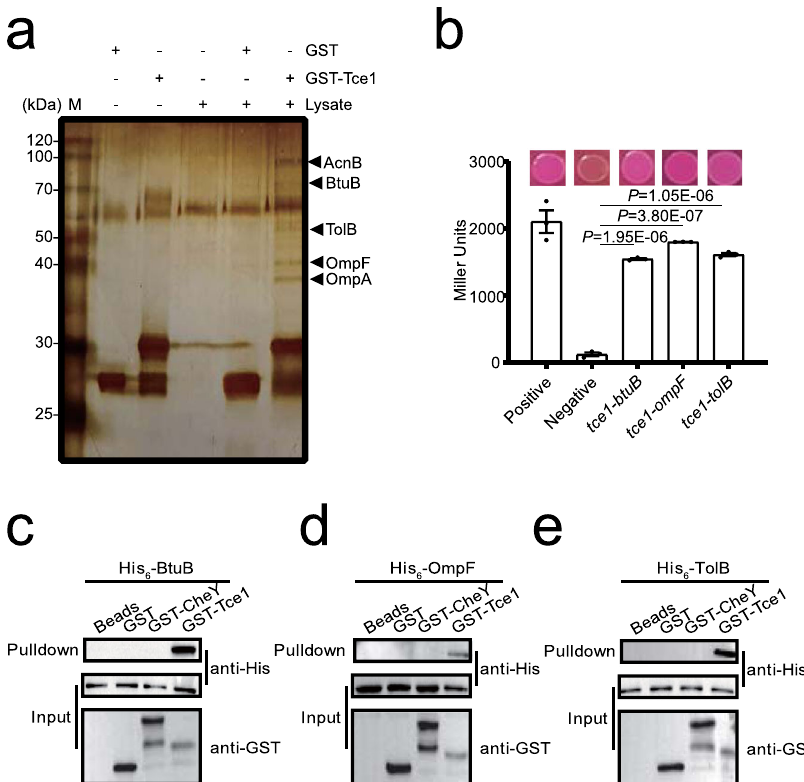
Fig. 3 Tce1 interacts with the outer membrane receptors BtuB and OmpF. a Identi fi cation of BtuB and OmpF as the binding partners of Tce1. Total cell lysates of Yptb YPIII were incubated with GST · Bind beads coated with GST-Tce1 or GST. After removing unbound proteins through extensive washing, the retained proteins were resolved through SDS – PAGE followed by silver staining. Protein bands speci fi cally retained by GST-Tce1 were identi fi ed through mass spectrometry. b Interactions between Tce1 and BtuB, OmpF or TolB detected using bacterial two-hybrid assay. Interactions were assessed using MacConkey maltose plates (upper) and the β -galactosidase assay (lower). Error bars indicate ±SD ( n = 3 biological replicates), with two-sided, unpaired Student ’ s t -test. P < 0.001 was considered as signi fi cant differences. c – e Direct binding between Tce1 and BtuB, OmpF or TolB detected using an in vitro GST pull-down assay. His 6 -BtuB ( c ), His 6 -OmpF ( d ), or His 6 -TolB ( e ) was incubated with GST-Tce1, GST, or an irrelevant recombinant protein GST-CheY, and the protein complexes captured on glutathione beads were detected using western blotting. All blots were repeated for at least three times independently with similar